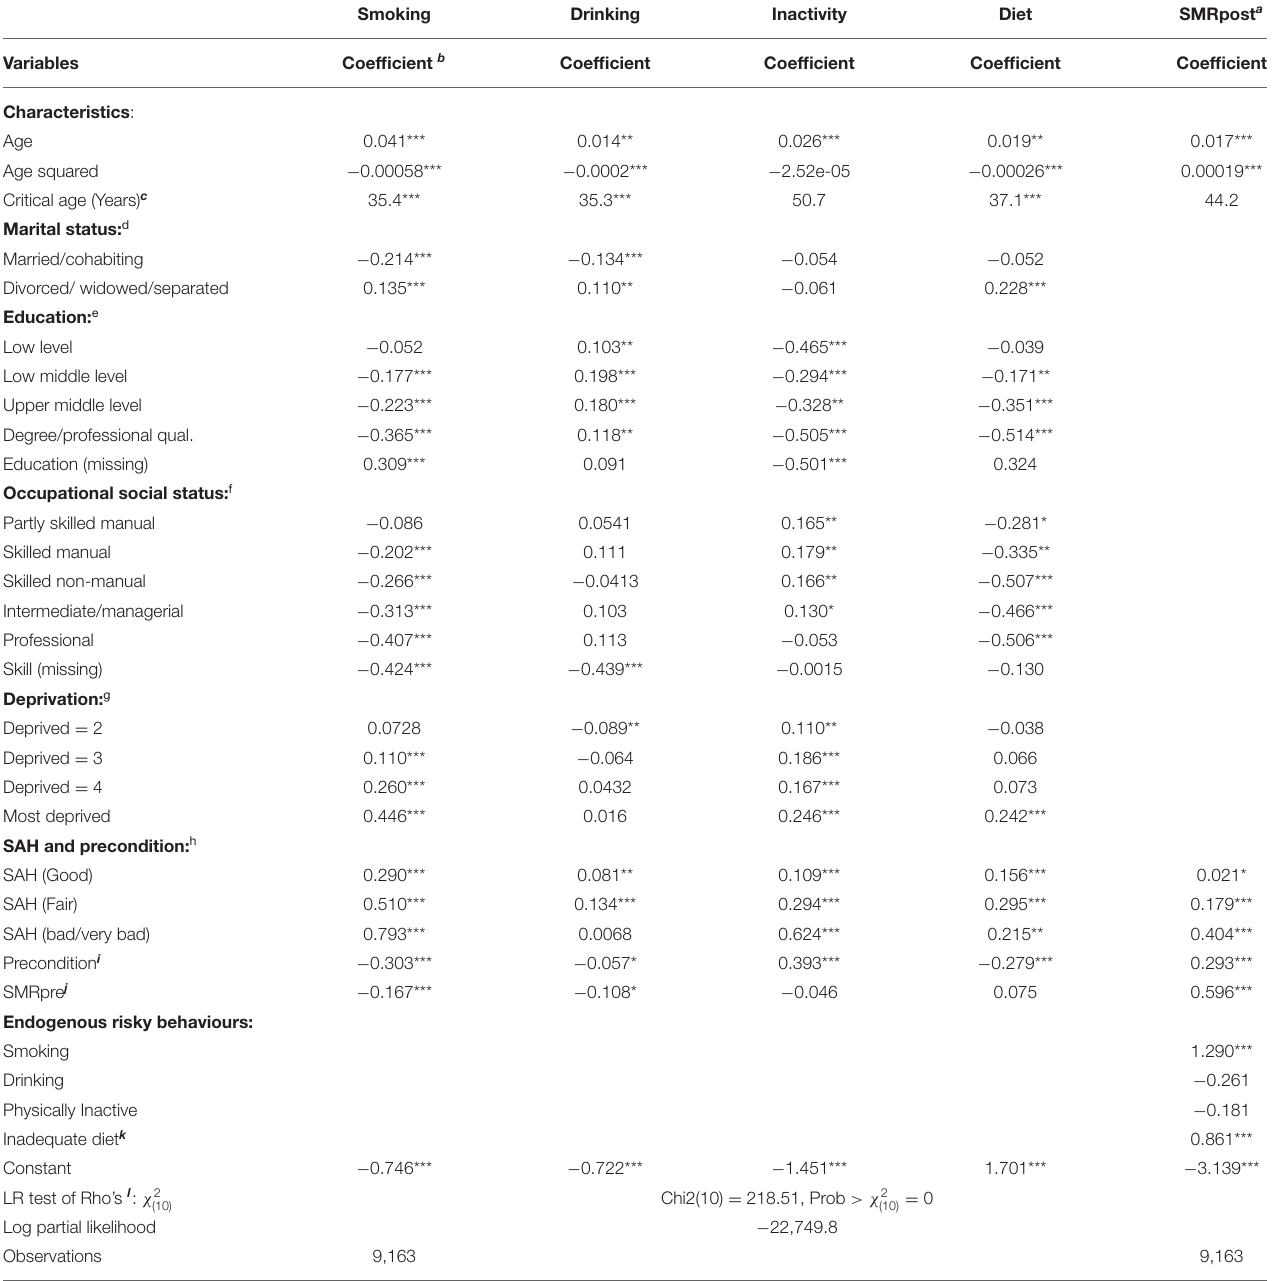
TABLE 4 | Recursive multivariate probit regression: